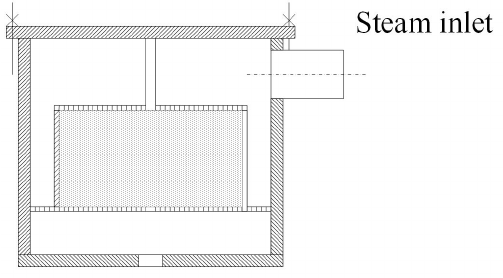
Figure 4. Schematic drawing of molding